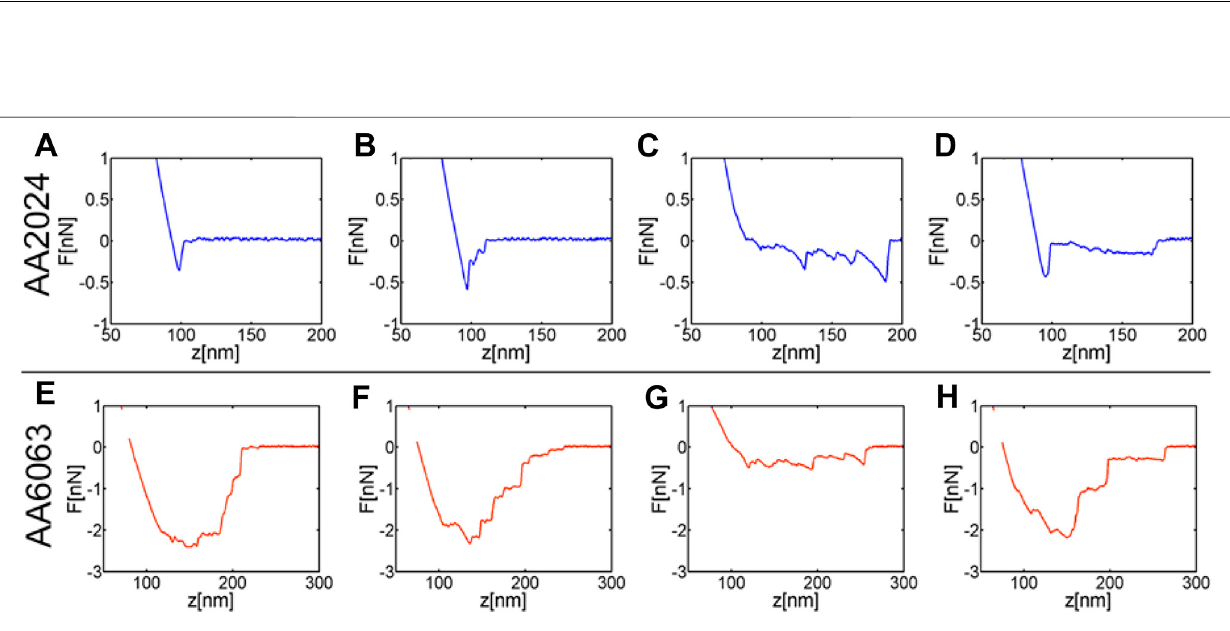
Frontiers in Bioengineering and Biotechnology |